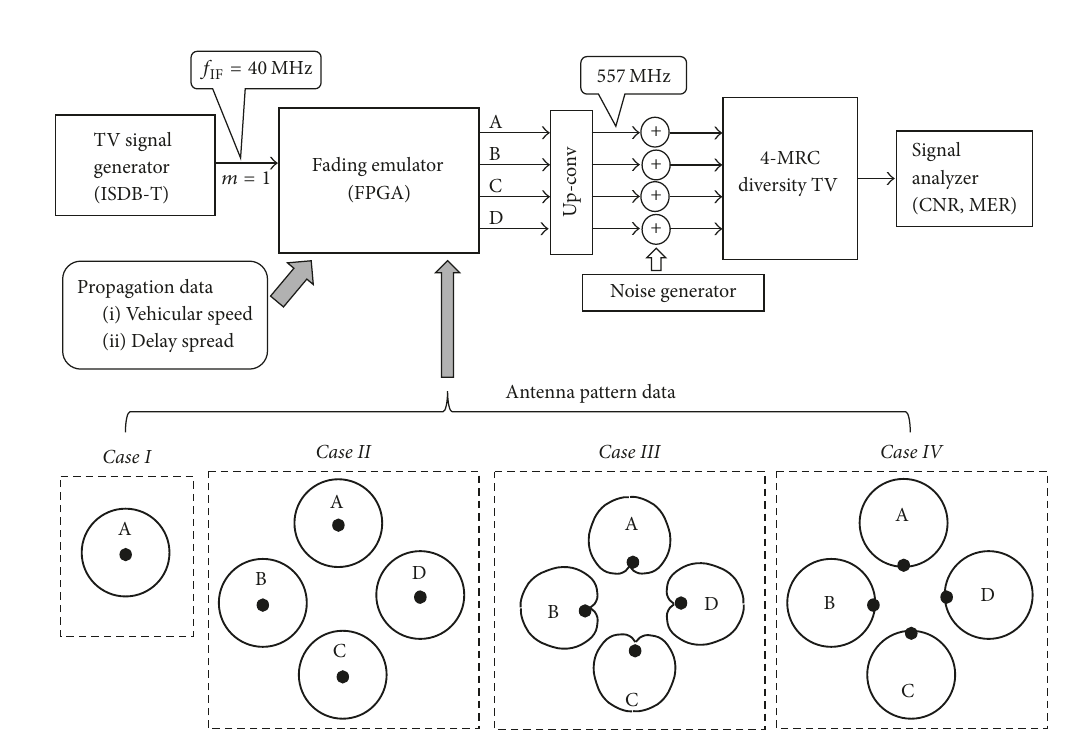
Figure 13: Experiment configuration for ISDB-T diversity characteristic